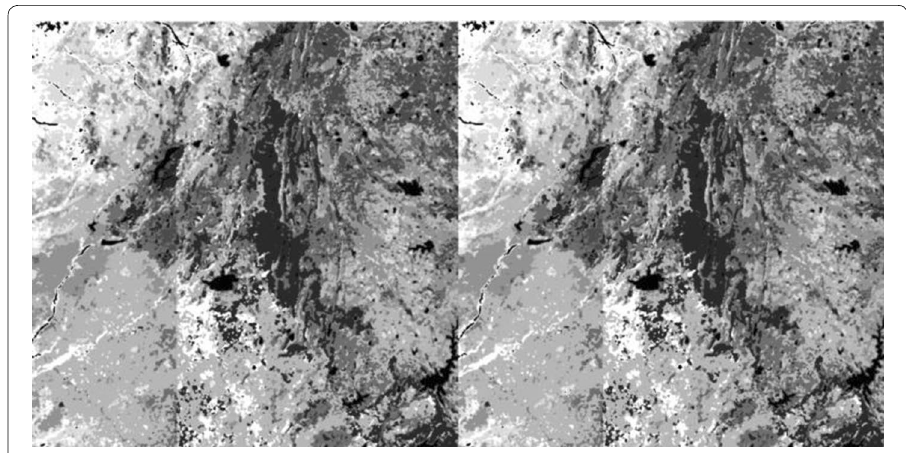
Fig. 15 Joining two copies of the same